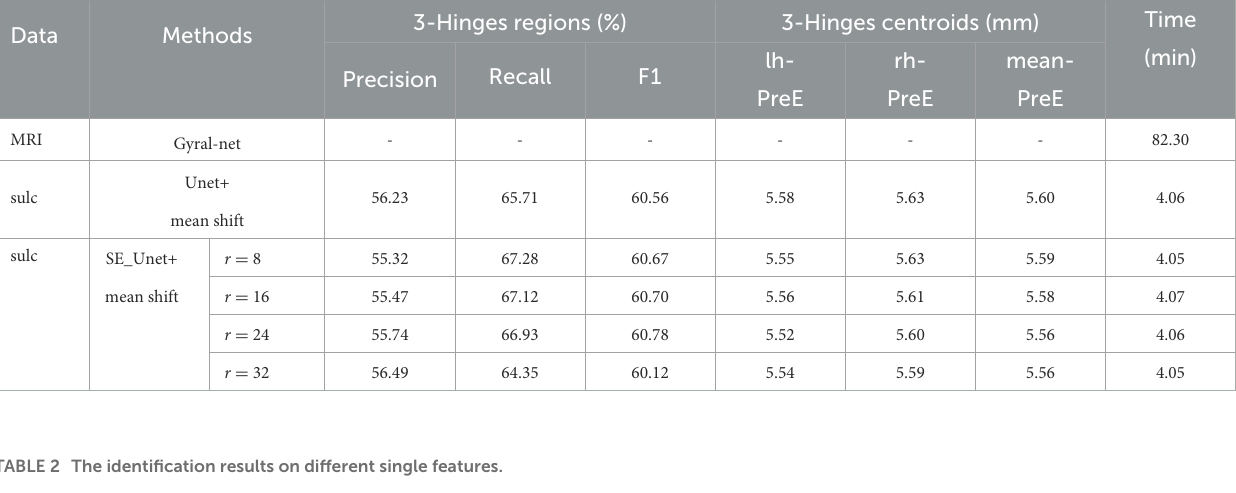
TABLE 1 The identification results of different methods.